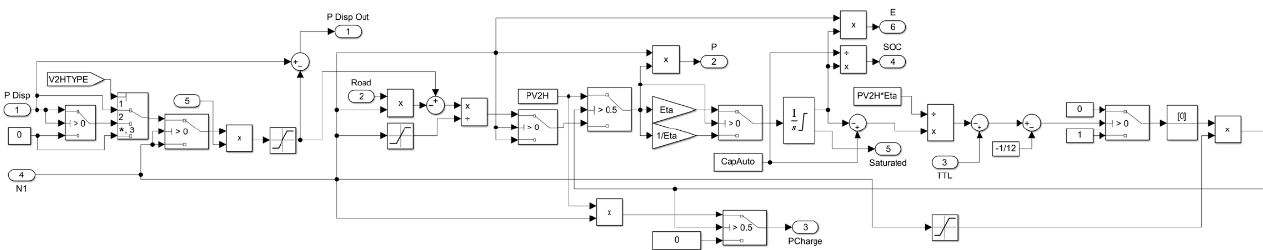
Figure 9. Block diagram of the implemented control strategy for the V2H